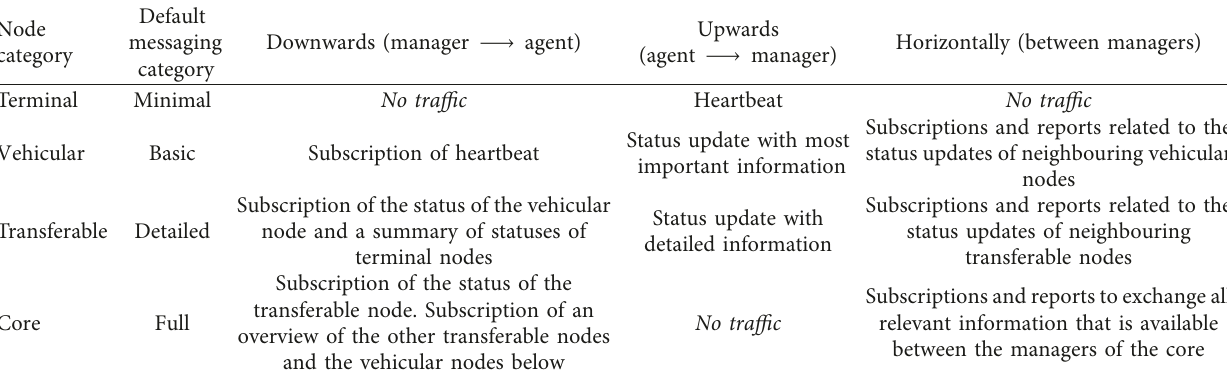
Table 2: DTN management messaging